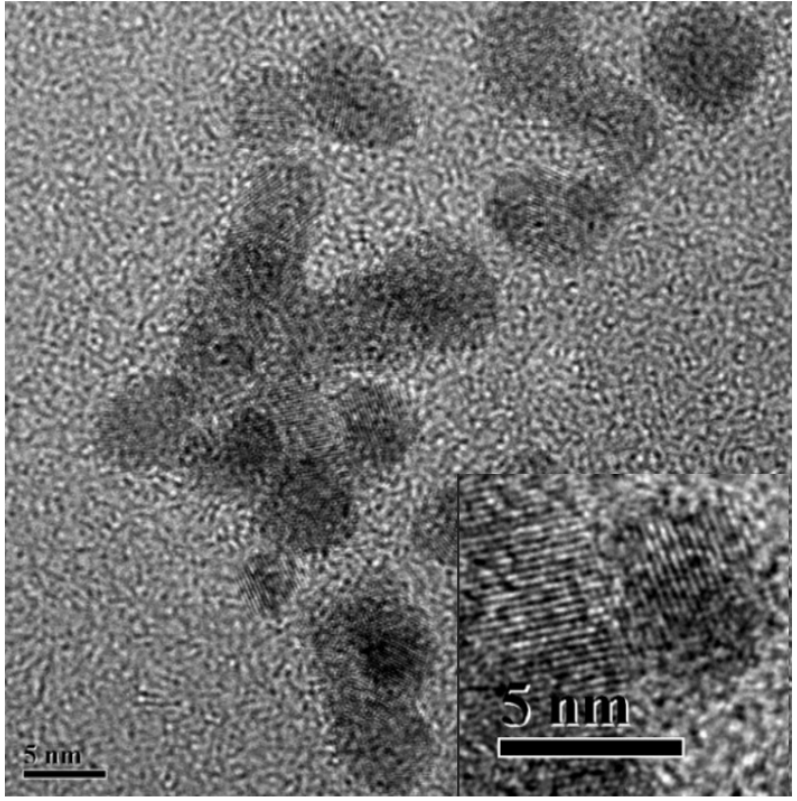
Figure 2. TEM images of poly 14 -N-CQDs (inset is high-resolution TEM image).